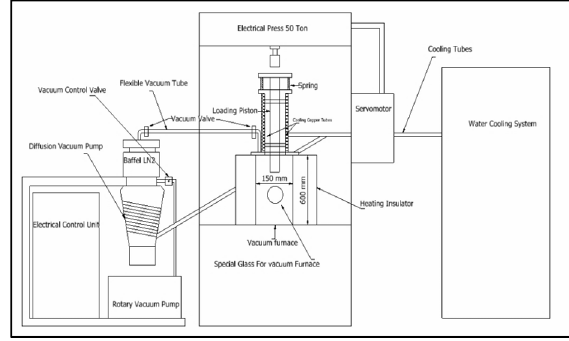
Fig . 1 . Vacuum Diffusion Bonding